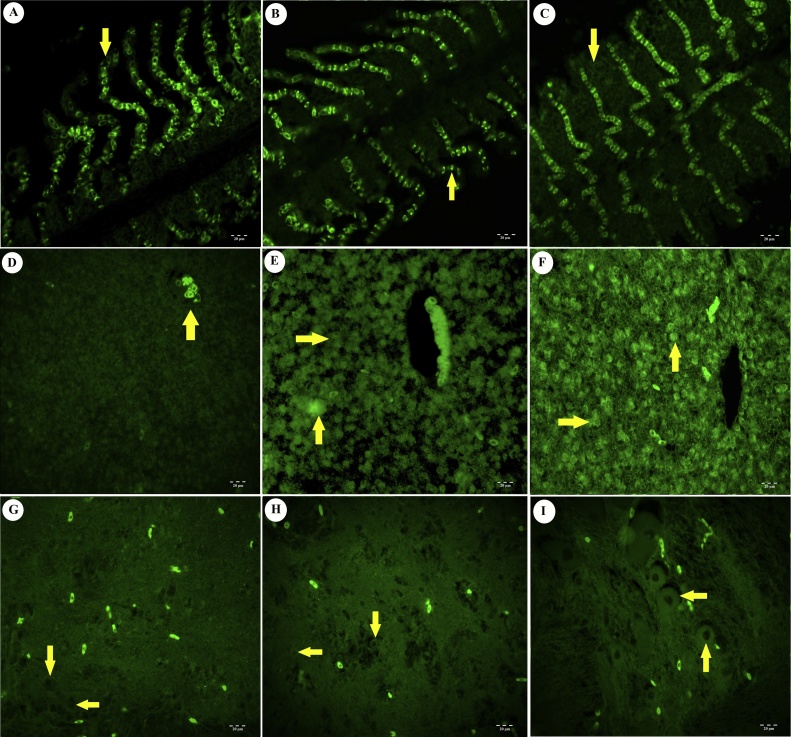
Immunoflorescence staining results of iNOS (96 h). A) Lamella of gill tissue (arrow). Control group. IF. 20 μm. B) Weak positive reaction in lamellar cells of gill tissue (arrows). Low dose toxic group. IF. 20 μm. C) Positivity in lamellar cells of gill tissue (arrow). High dose toxic group. IF. 20 μm. D) Liver tissue, vena centralis (arrow). Control group. IF. 20 μm. E) Positive reactions in hepatocytes (arrows). Low dose toxic group. IF. 20 μm. F) Positive reactions in hepatocytes (arrows). High dose toxic group. IF. 20 μm. G) Weak positive reactions in neurons (arrows). Control group. IF. 20 μm. H) Positivity in neurons (arrows). Low dose toxic group. IF. 20 μm. I) Positivity in neurons (arrows). High dose toxic group. IF. 20 μm.